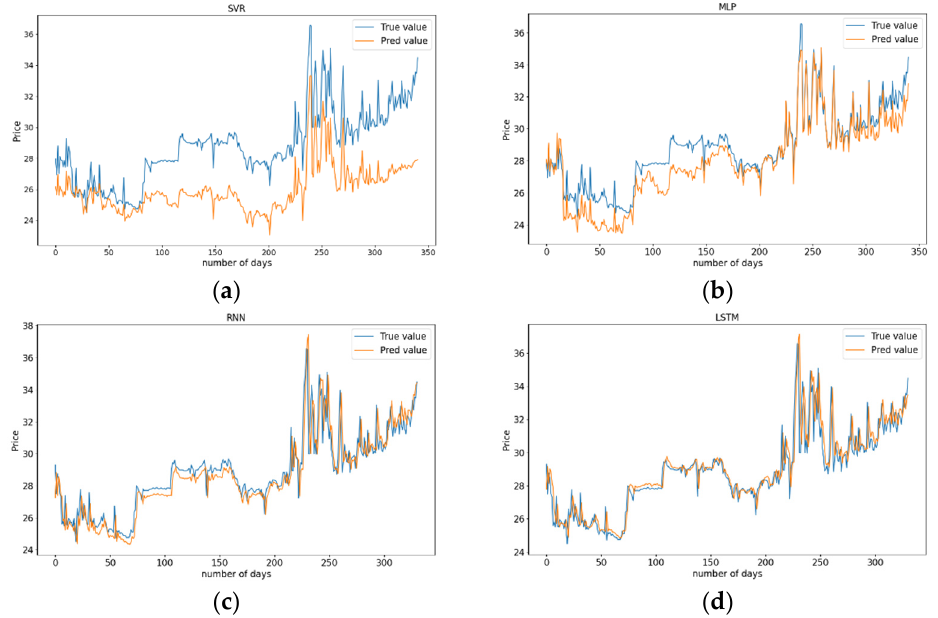
Figure 6. Models predicted and actual HBEA values. ( a ) SVR; ( b ) MLP; ( c ) RNN; ( d ) LSTM.